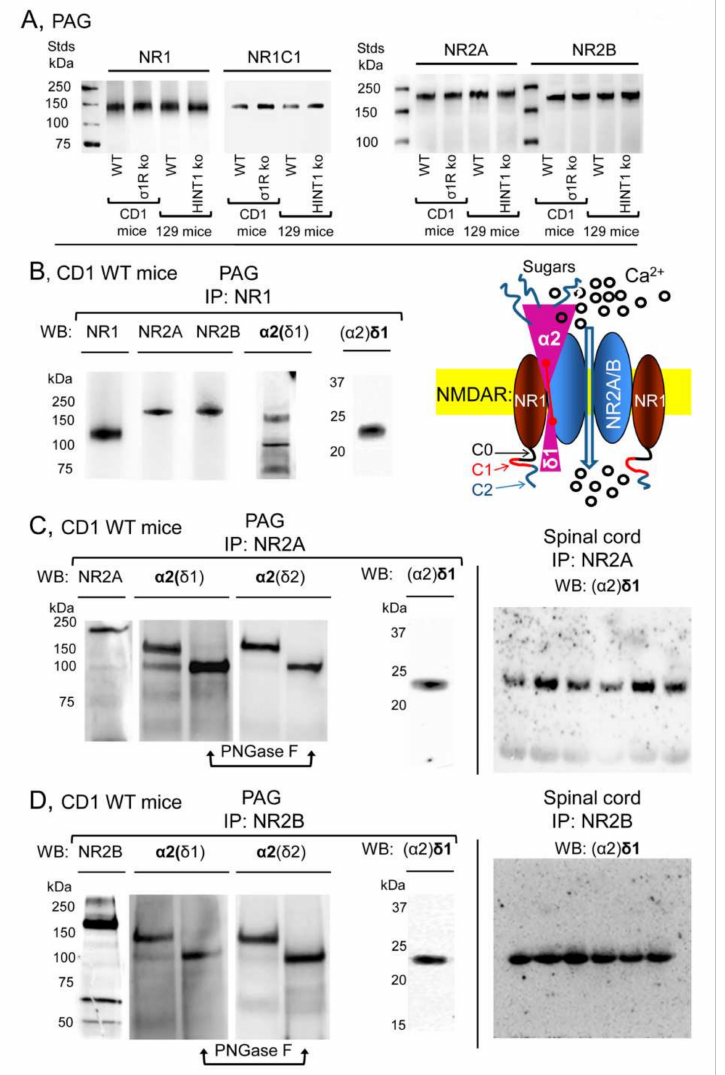
Figure 2. Expression of NR1, NR2A, and NR2B subunits of glutamate NMDARs in mouse PAG: Co- precipitation with α 2( δ 1), α 2( δ 2), and ( α 2) δ 1 proteins. ( A ) PAG P2 fractions enriched in synaptosomes from the CD1 WT, CD1 σ 1R − / − , 129 WT, and 129 HINT1 − / − mice of Figure 1B,C, were used. About 60 µ g protein/lane was resolved by SDS-PAGE and examined in Western blots that were probed